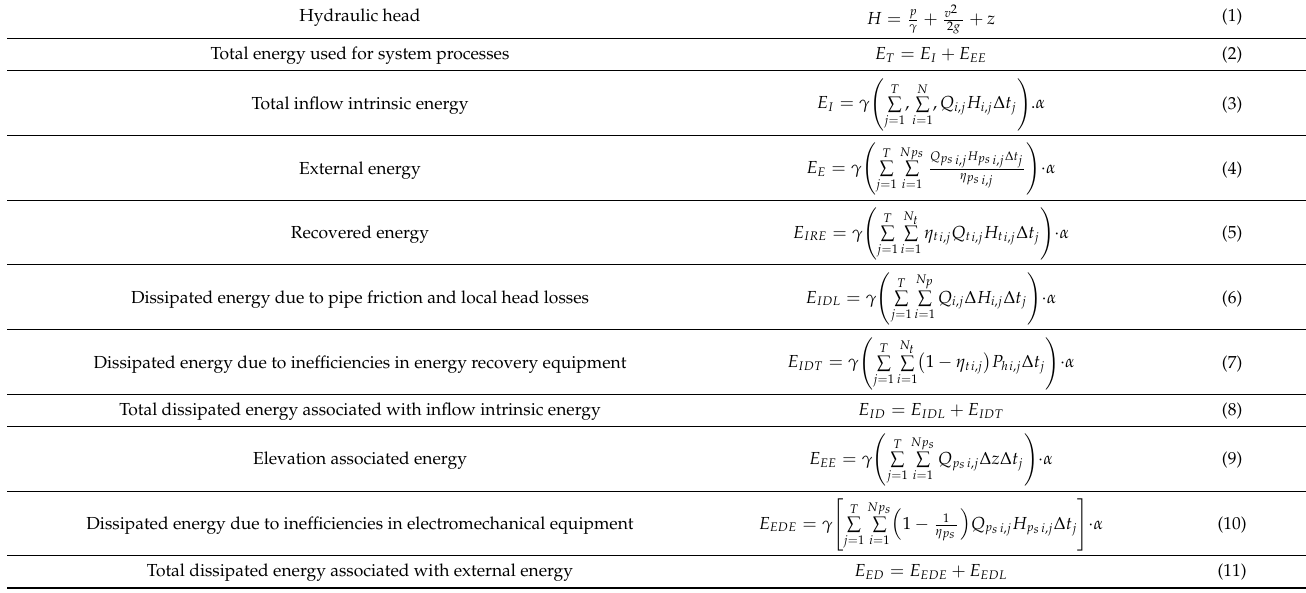
Table 2. Equations for calculating the energy balance